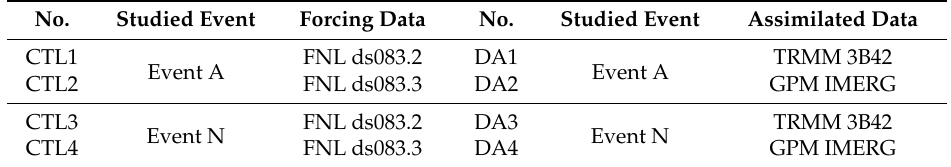
Table 2. Designs of the WRF control (CTL) experiments and the WRF data assimilation (DA) experiments.